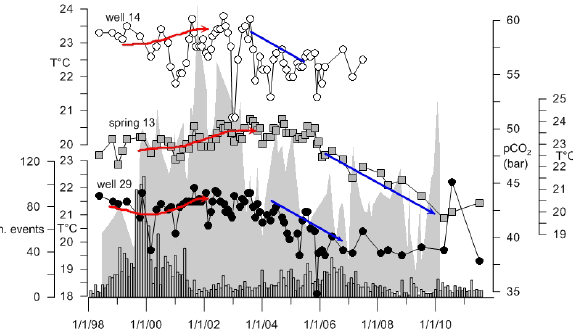
Figure 4. Time trends of water temperature at wells 29 and 14 and spring 13. Arrows indicate phases of increases (red) and decreases (blue) in temperature. The time trend of pCO values, computed for 2 the hydrothermal aquifer by Caliro et al. [2011], is plotted as a shaded area. The histogram shows the monthly number of seismic